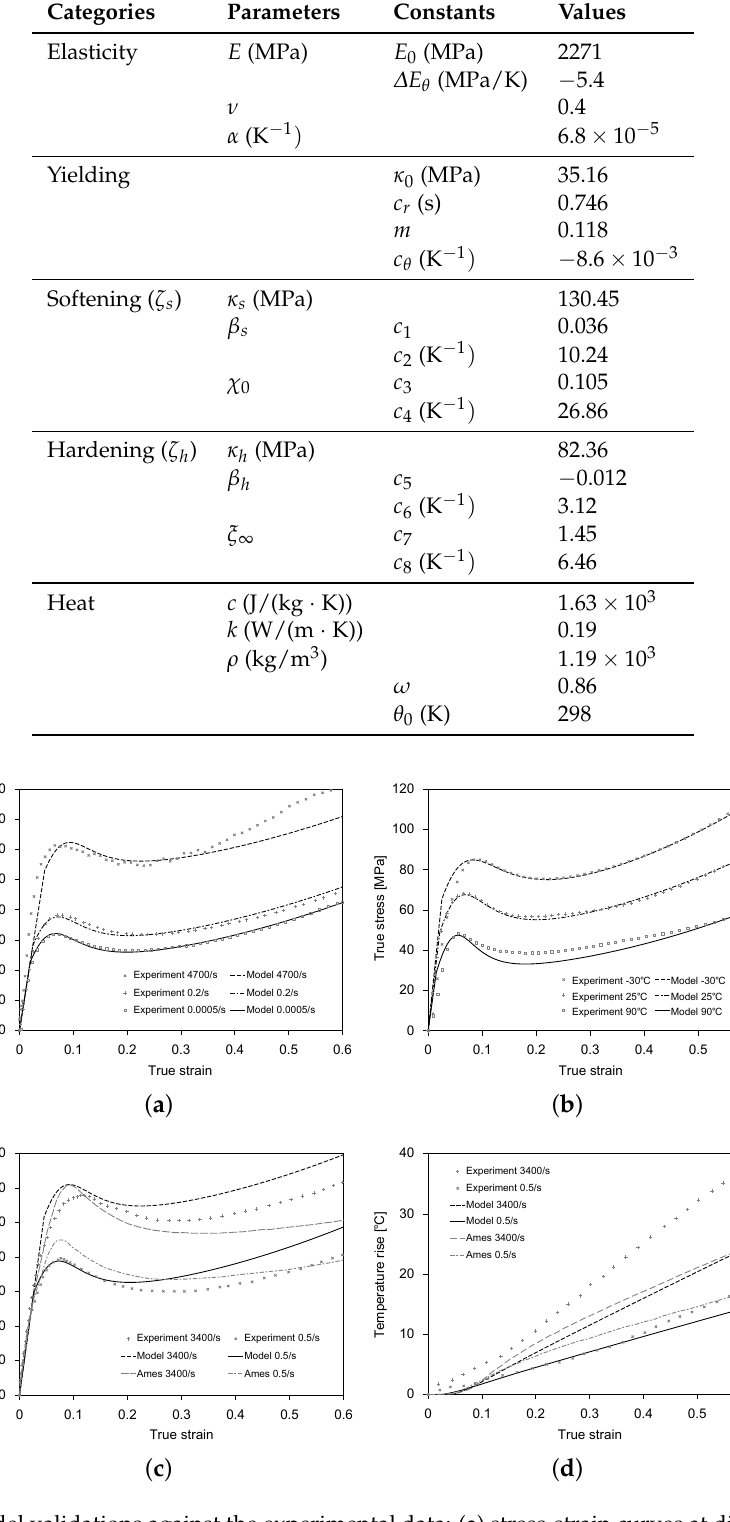
Table 2. Model parameters used in the present simulations.